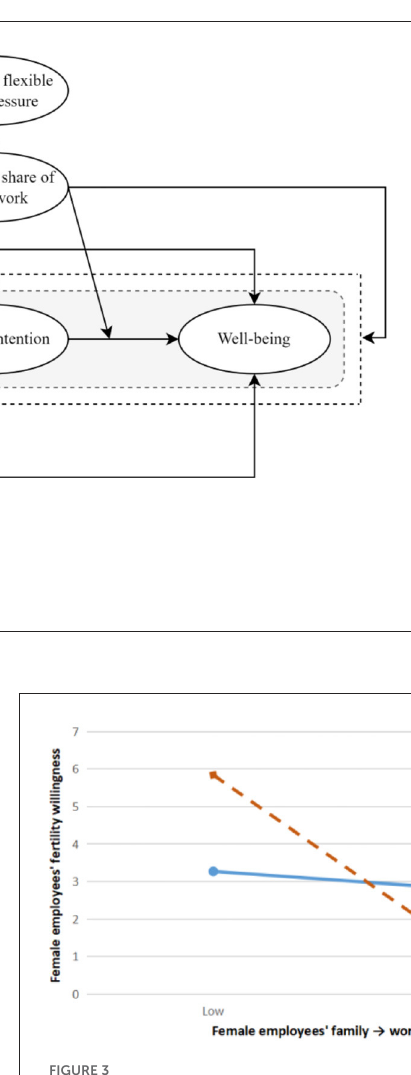
FIGURE2 Moderating effect of husband’s share of housework on the relationship between work → family conflict and fertility intention of female employees.